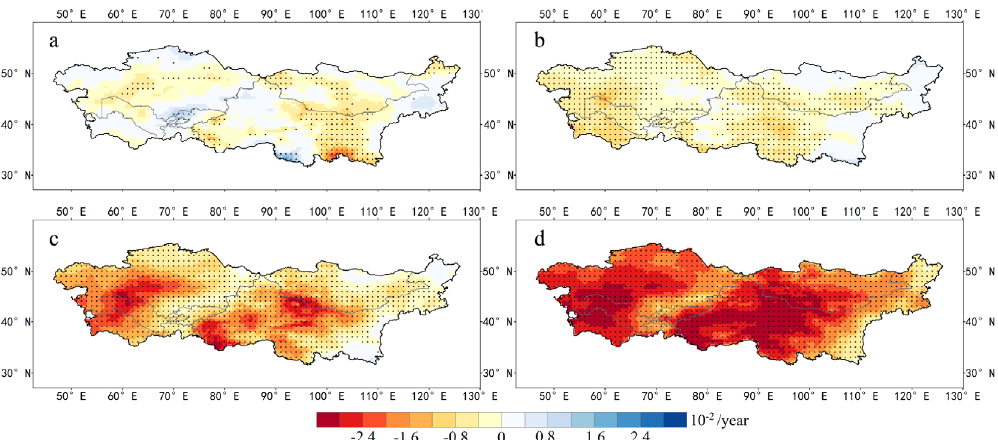
Figure 4. Spatial distribution of estimated Sen's slope of monthly SPEI values for ( a ) the historical period and the three future paths of ( b ) SSP126, ( c ) SSP245, and ( d ) SSP585 in the drylands of Asia. The dot in the figure indicates that the region exceeds the Mann–Kendall significance test (0.05).